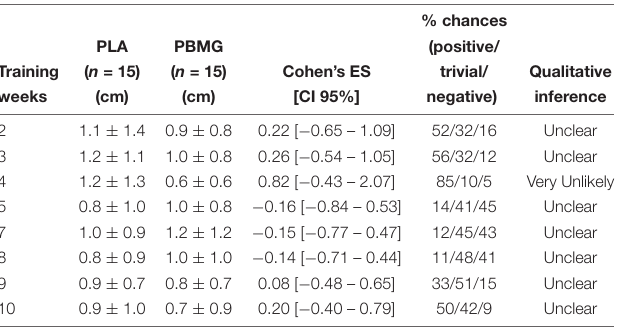
TABLE 5 | Muscle soreness responses evaluated by visual analogic scale (VAS) during weeks of running